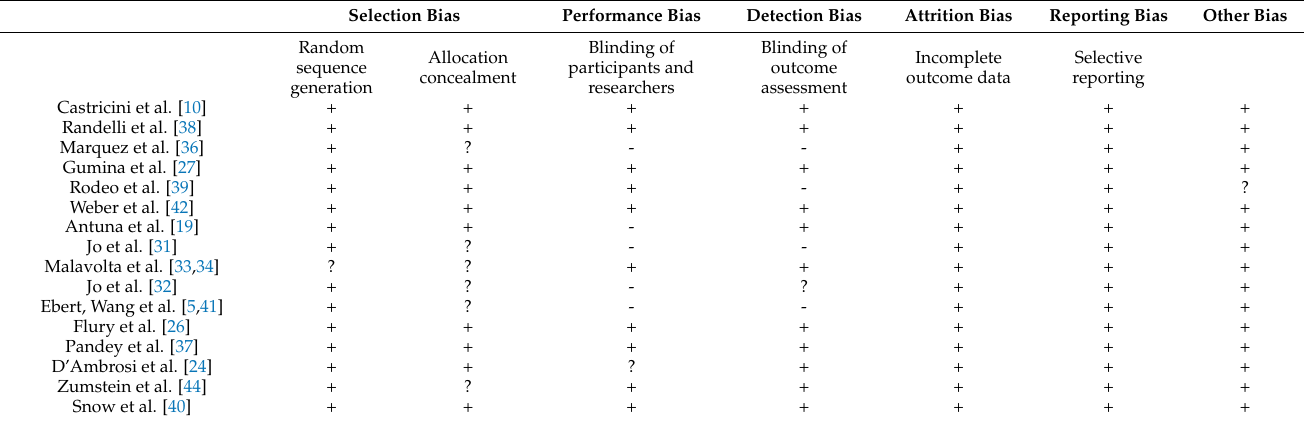
Table 1. Risk-of-bias assessment for randomized studies according to the Cochrane collabora- tion’s